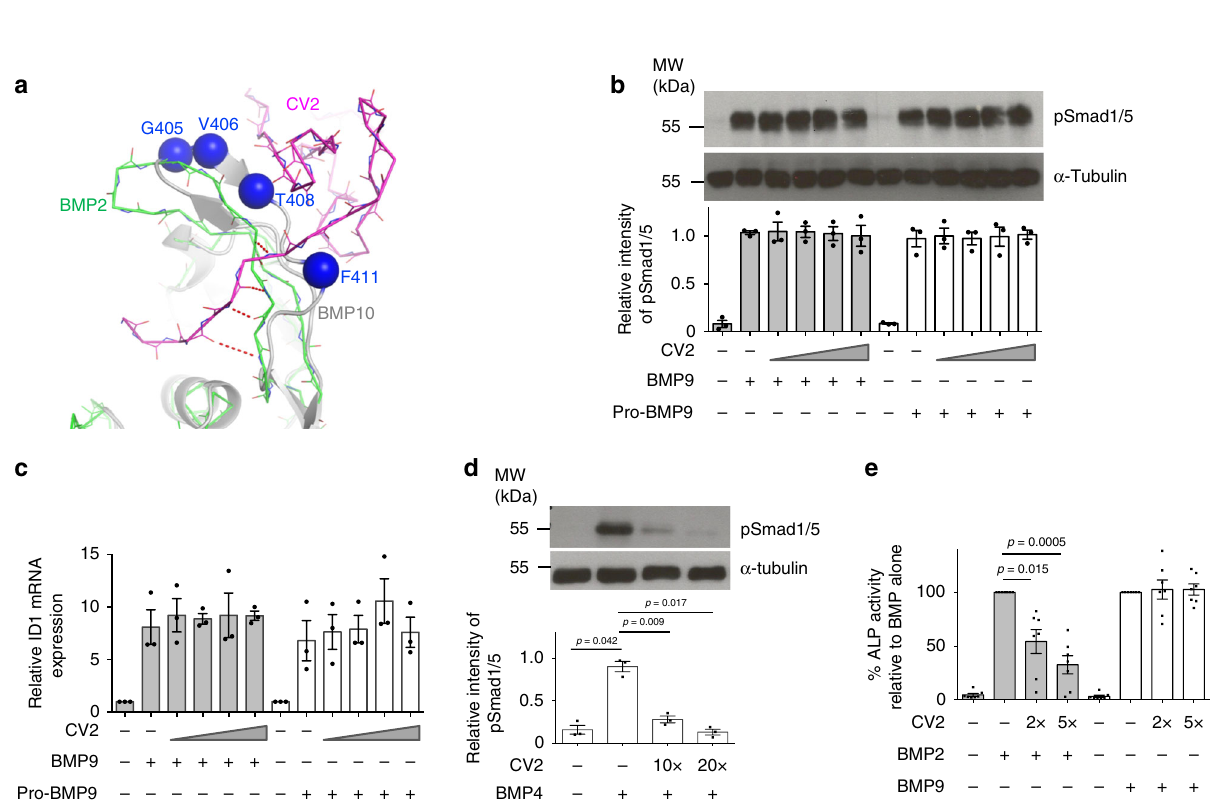
Fig. 7 CV2 does not inhibit BMP9 signalling. a Structural analysis. BMP10 (grey, with conserved region 2 residues in blue spheres) was overlaid onto the BMP2:CV2 structure (PDB:3BK3, CV2 in magenta and BMP2 in green). Four mainchain H-bonds that stabilise the BMP2:CV2 β -sheet interaction are shown. BMP9 has the same conformation as BMP10 in this region. b , c CV2 does not inhibit BMP9 signalling in PAECs. Serum-starved PAECs were treated with BMP9 or pro-BMP9 (at 1 ng ml − 1 GF-domain concentration) without or with CV2 at 10-fold, 20-fold, 50-fold or 250-fold molar excess for 15 min to assess Smad1/5 phosphorylation using immunoblots ( b ) or for 1 h to assess ID1 gene expression using qPCR ( c ). One representative of three independent experiments is shown in b . Band intensity was quanti fi ed using Image J (version 1.51s). d CV2 inhibits BMP4 signalling in PASMCs. Serum-starved PASMCs were treated with BMP4 (25 ng ml − 1 ) without or with CV2 at indicated molar excess for 15 min. Immunoblots and quanti fi cation were carried out as above. N